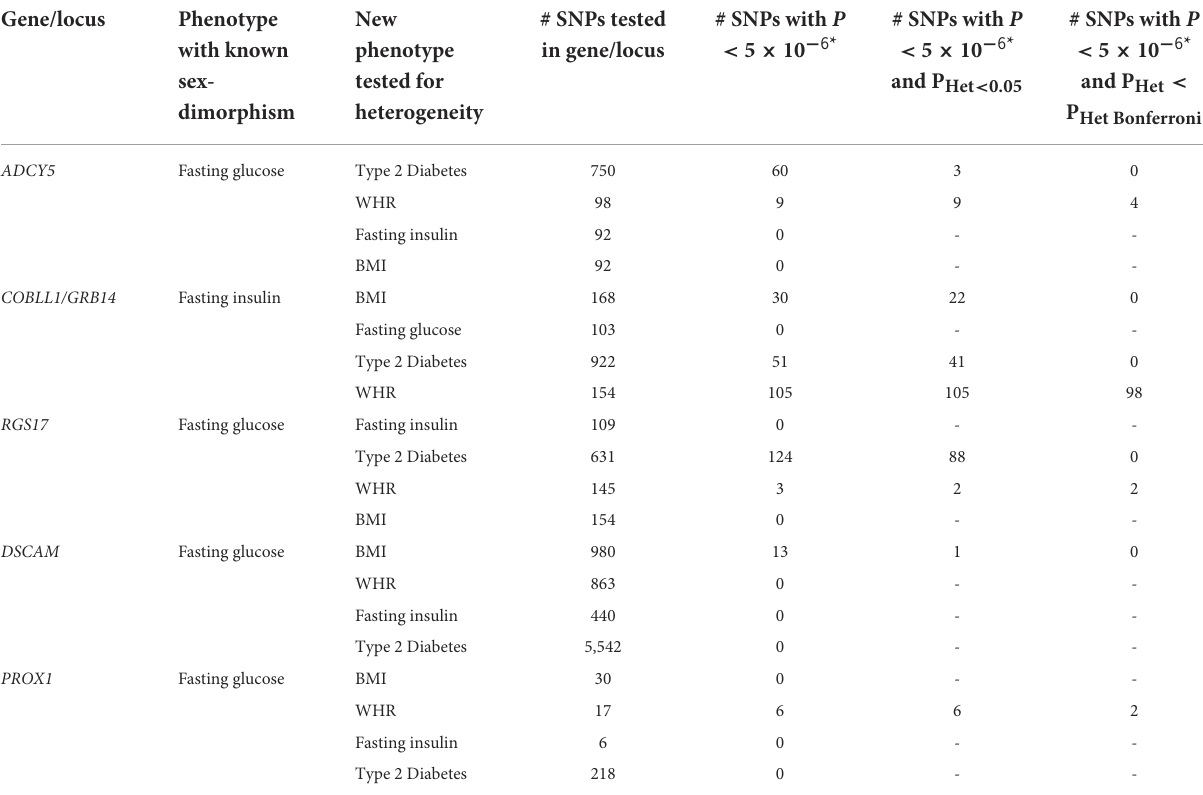
TABLE 2 Summary of cross-phenotype sex-heterogeneity tests in BMI, WHR, T2D, FG, and FI consortium data at genetic loci with previously known sex-dimorphism.